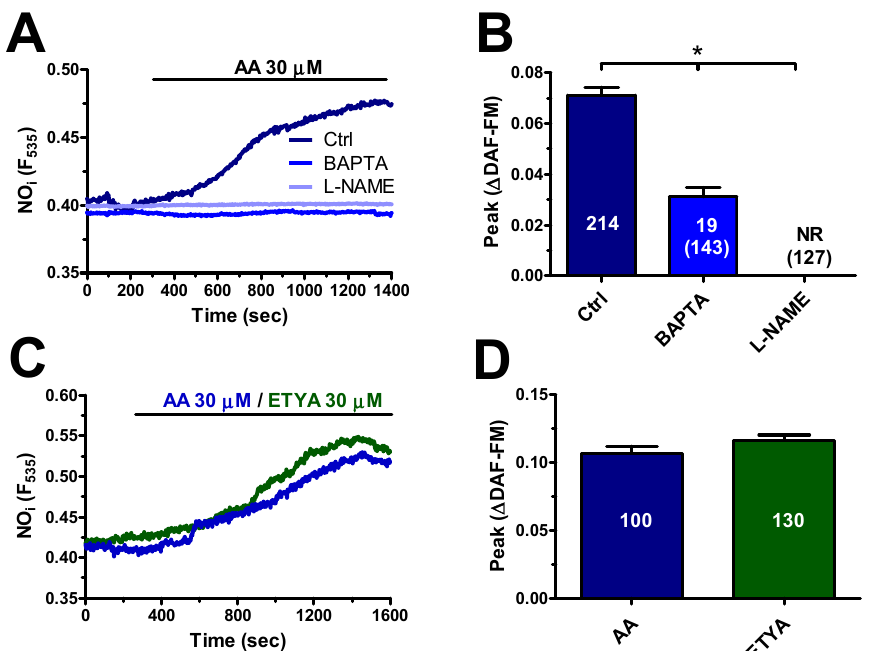
Figure 7. Arachidonic acid induces NO release in a Ca 2 + -dependent manner in hCMEC / D3 cells. ( A ) AA (20 µ M) evoked a robust increase in the fluorescence in hCMEC / D3 cells loaded with the NO-selective fluorophore, 4-amino-5-methylamino-2’,7’-difluorofluorescein (DAF-FM). AA-elicited NO release was abrogated by L-N G -Nitro-L-arginine methyl ester (L-NAME; 100 µ M, 1 h) or BAPTA (30 µ M, 2 h). ( B ) Mean ± SE of the amplitude of AA-elicited NO release under the designated treatments. For L-NAME and BAPTA, the number of total cells analysed is indicated in the brackets. The asterisk indicates p < 0.05. ( C ) AA (30 µ M) and ETYA (30 µ M) induced an increase in DAF-FM fluorescence with overlapping kinetics and amplitude. ( D ) Mean ± SE of the amplitude of AA- and ETYA-evoked NO release in hCMEC / D3 cells. NR means no response.